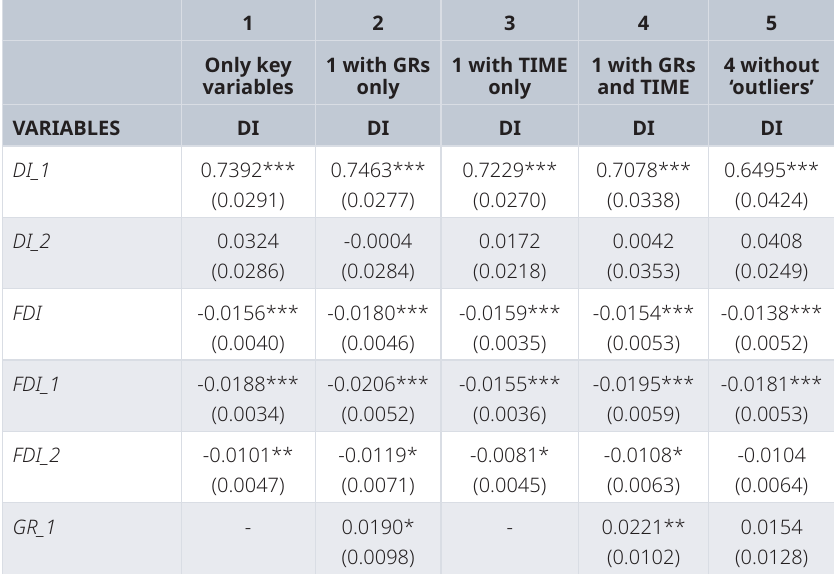
Table 5. Results of sensitivity analysis of the estimations for the level of development and FDI on DI.